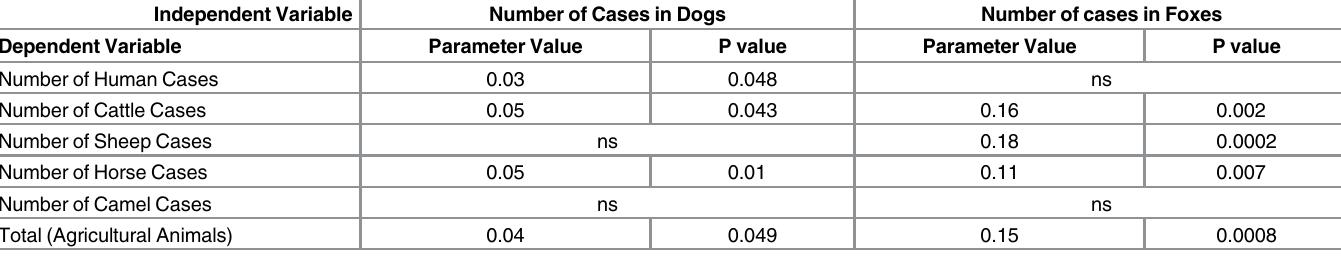
Table 1. Results of GLM or regression of numbers of confirmed cases of humans or agricultural animals against the numbers of confirmed cases in fox and dogs by oblast. Independent